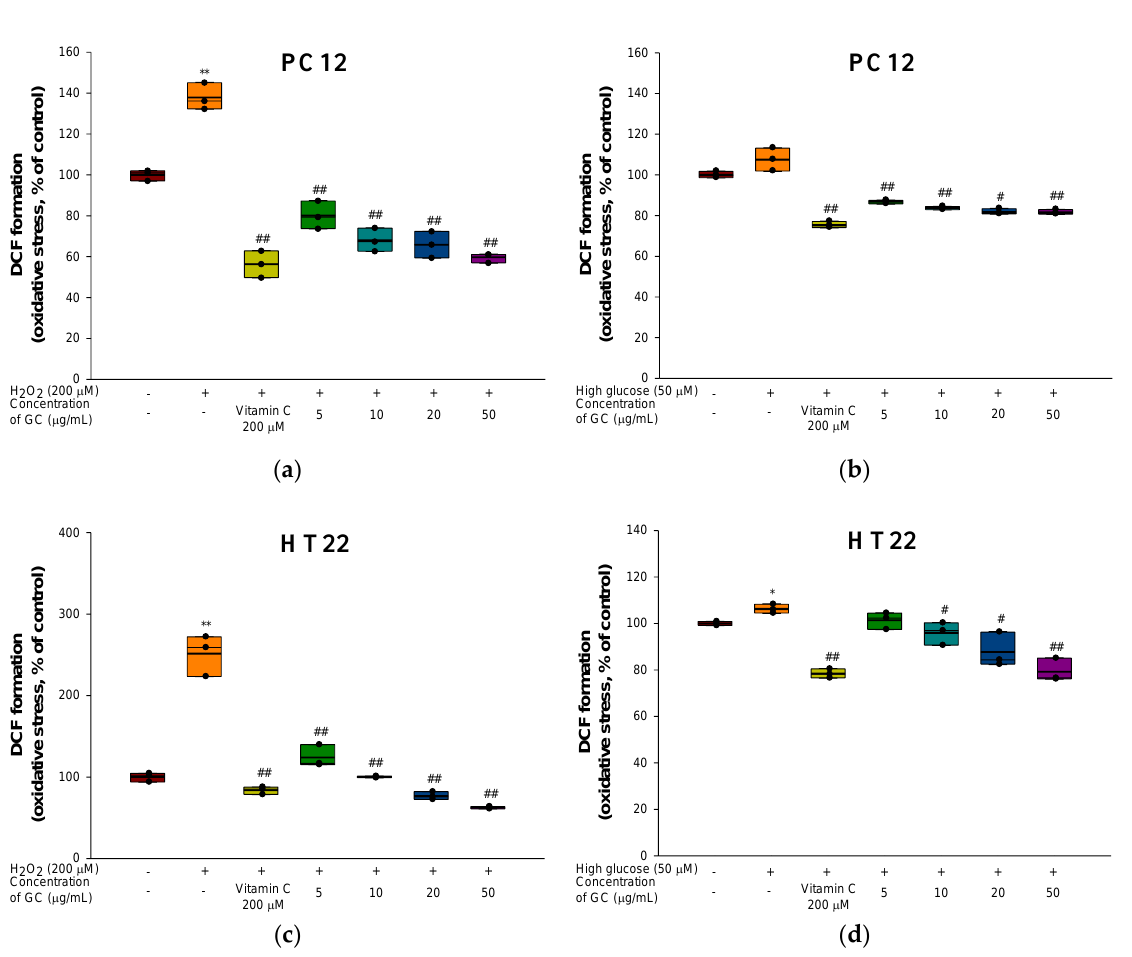
Figure 3. Protective effect of 80% ethanolic extract from Gimcheon 1ho (GC) cultivar walnut ( Juglans regia ): ( a ) ROS production from H 2 O 2 -induced cytotoxicity in PC12 cells; ( b ) ROS production from high glucose-induced cytotoxicity in PC12 cells; ( c ) ROS production from H 2 O 2 -induced cytotoxicity in HT22 cells; ( d ) ROS production from high glucose-induced cytotoxicity in HT22 cells. Results shown are mean ± SD ( n = 3). Data are statistically represented with * = significantly different from the NC group, and # = significantly different from PM group; * and # p < 0.05, ** and ## p < 0.01. Bold line indicates mean.